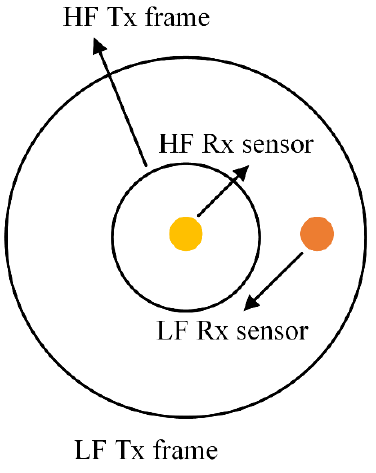
Figure 2. Overall layout of the transmitter–receiver coils .